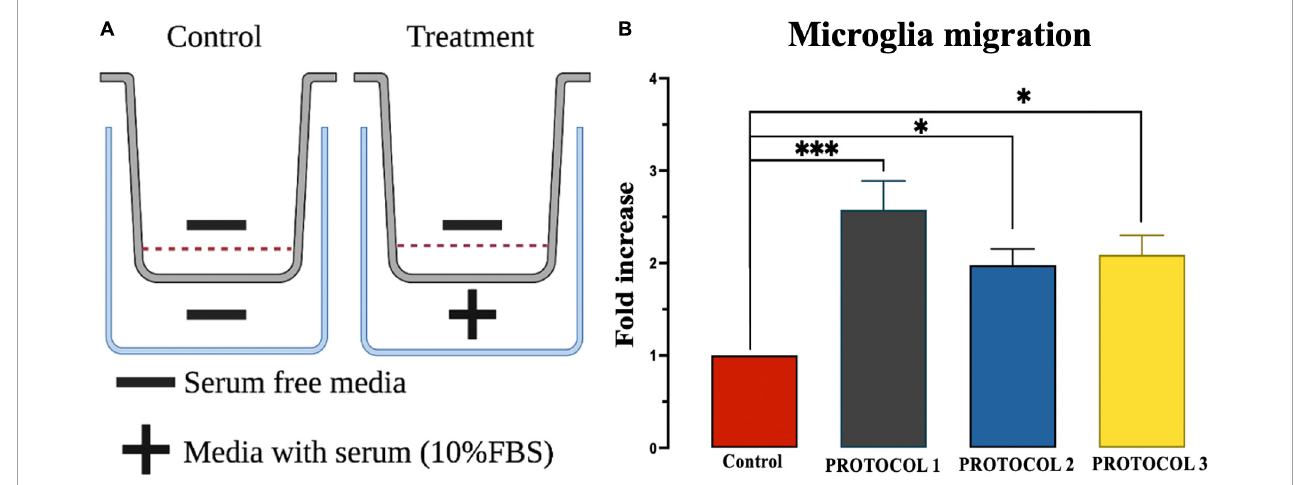
FIGURE9 Evaluation of microglia migration. (A) Overview of chemotaxis setup. (B) Migration was assessed using chemotaxis chambers and analyzed by UV spectroscopy at 570 nm wavelength. Results were expressed as calorimetric intensity of the migrating cell compared to control cells. Data are presented as mean ± SEM; *** p < 0.001 and * p < 0.05 compared to the